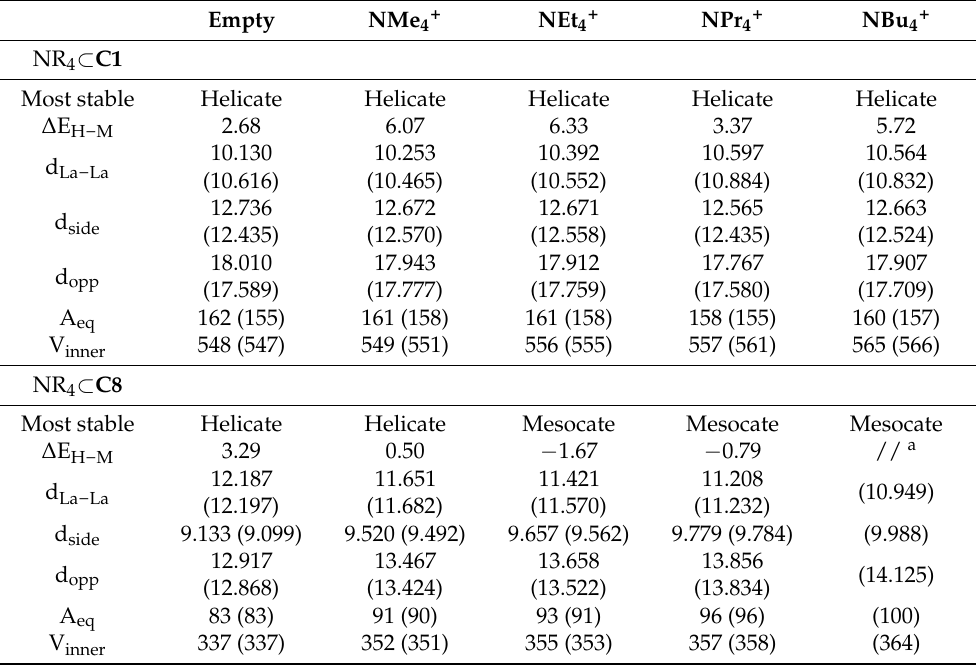
Table 3. Geometrical parameters and energy differences ∆ E H–M between helicate and mesocate isomer for calculations with solvent. Distances are in Å, areas are in Å 2 , volumes are in Å 3 , while ∆ E H–M are in kcal/mol. Mesocate values are reported in parentheses. A that the mesocate is the most stable